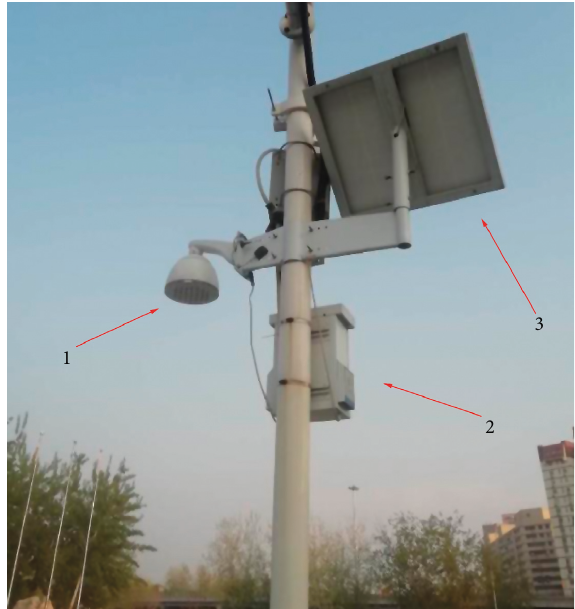
Figure 1: Air pollution monitor (1 is the device monitoring probe, 2 is the equipment power supply box, and 3 is the solar electronic board).